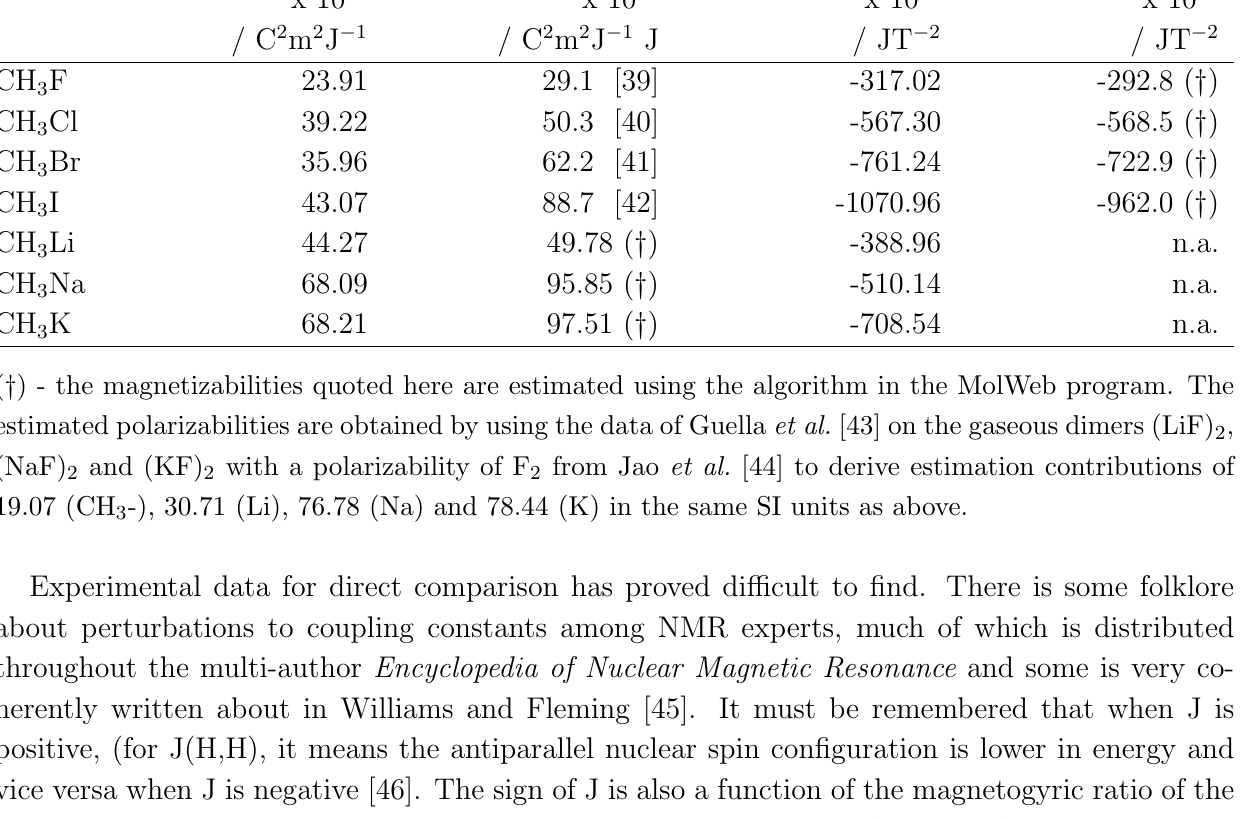
Table 4. Some Calculated Polarizabilities and Magnetizabilities Compared to Experiment